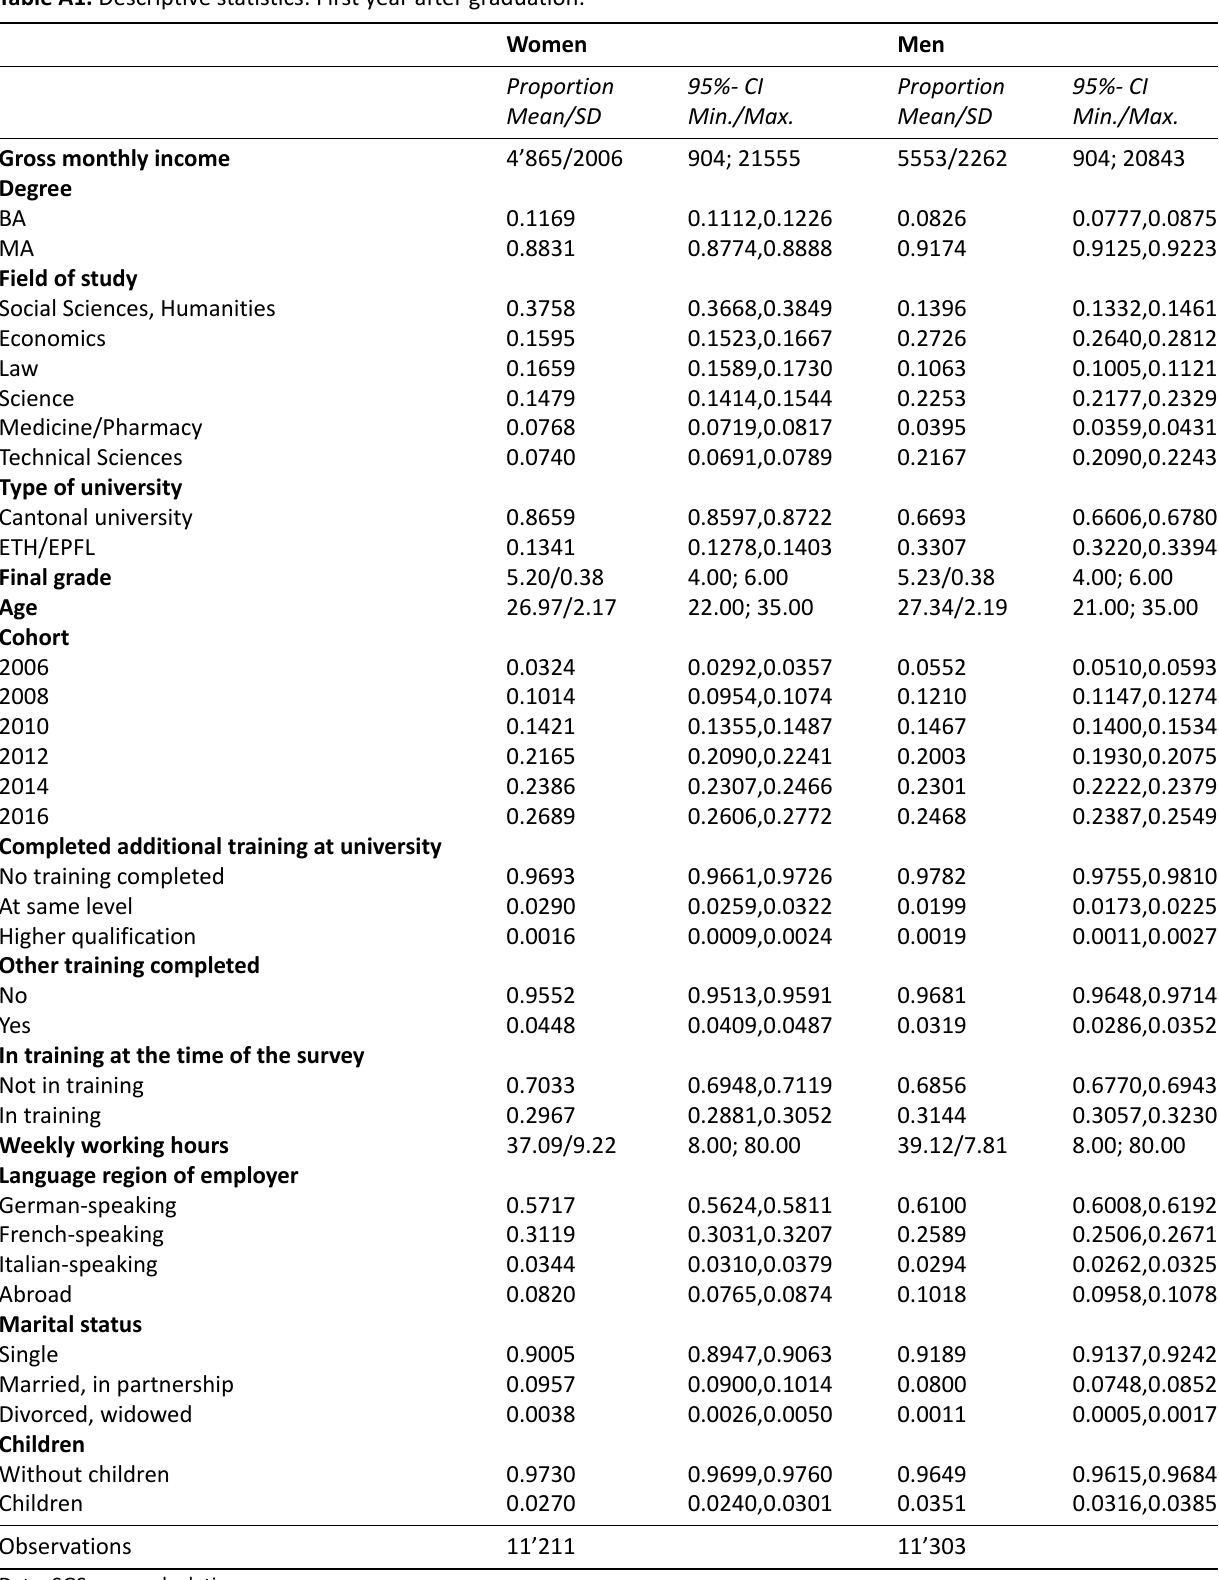
Table A1. Descriptive statistics: First year after